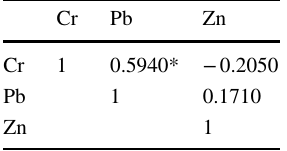
Fig. 1 Hazard quotient (HQ) representing the non-cancer risk